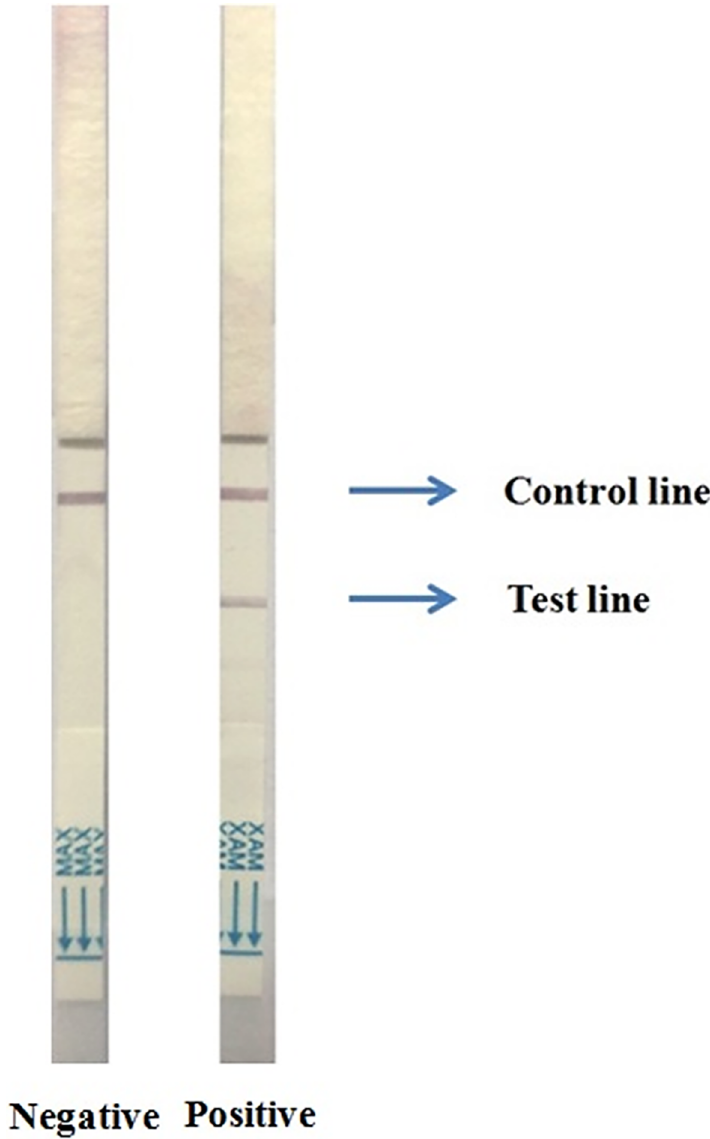
Fig 1. Two Cholkit dipsticks showing characteristic negative (left image) and positive (right image) results after 15 min sample run.